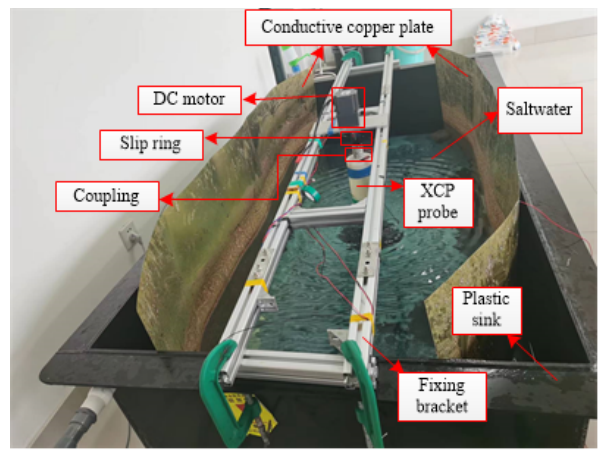
Figure 15. Photo of the experimental environment.